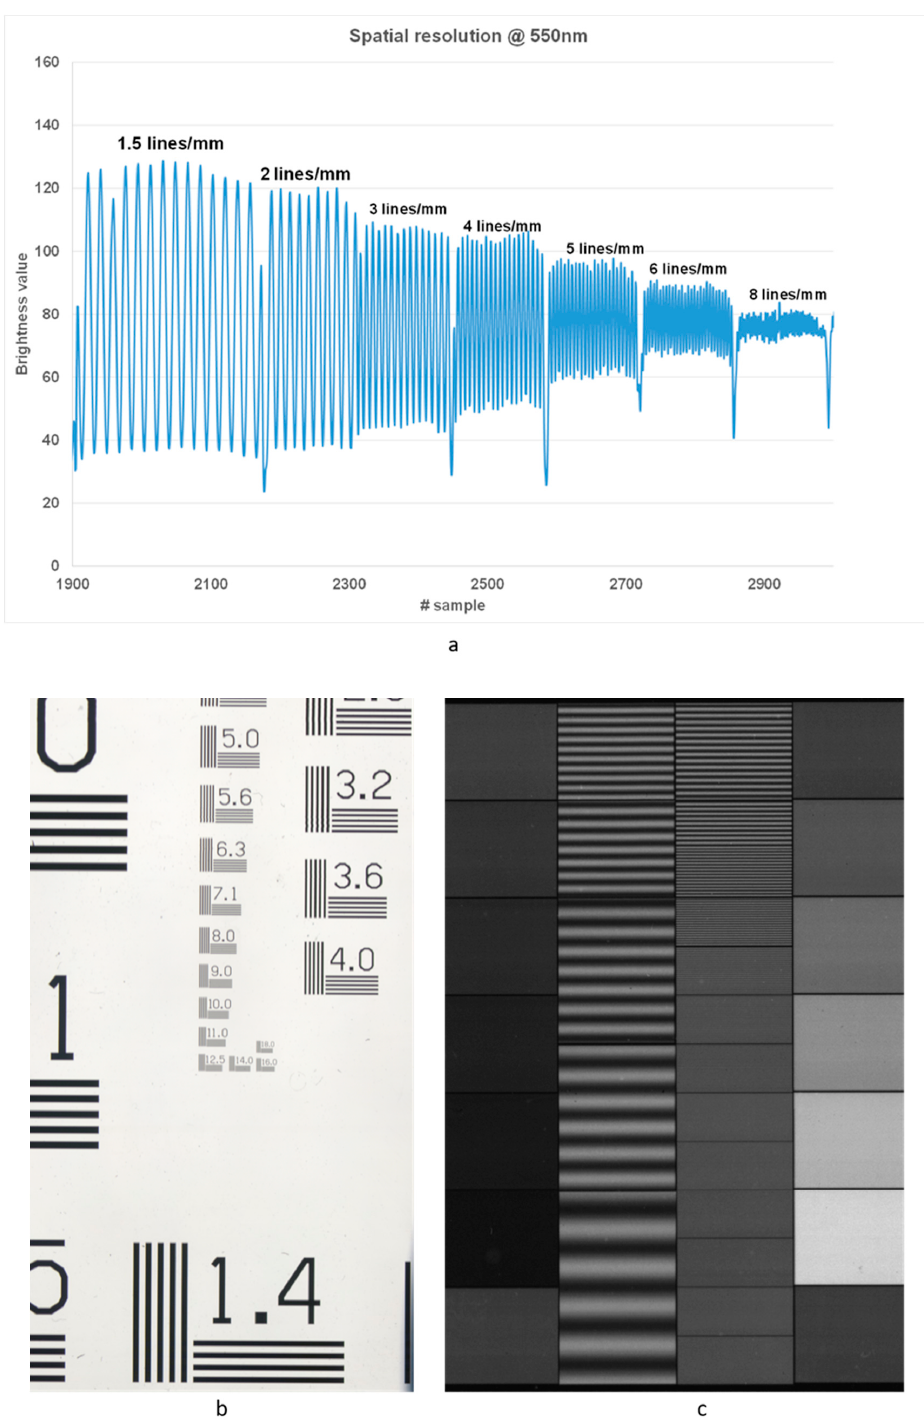
Figure 2. ( a ) Plot of contrast function in the image of the sinusoidal pattern HR target acquired at 550 nm. ( b ) The image acquired at 550 nm of the 1951 USAF target; ( c ) Image at 550 nm of the HR sinusoidal target.